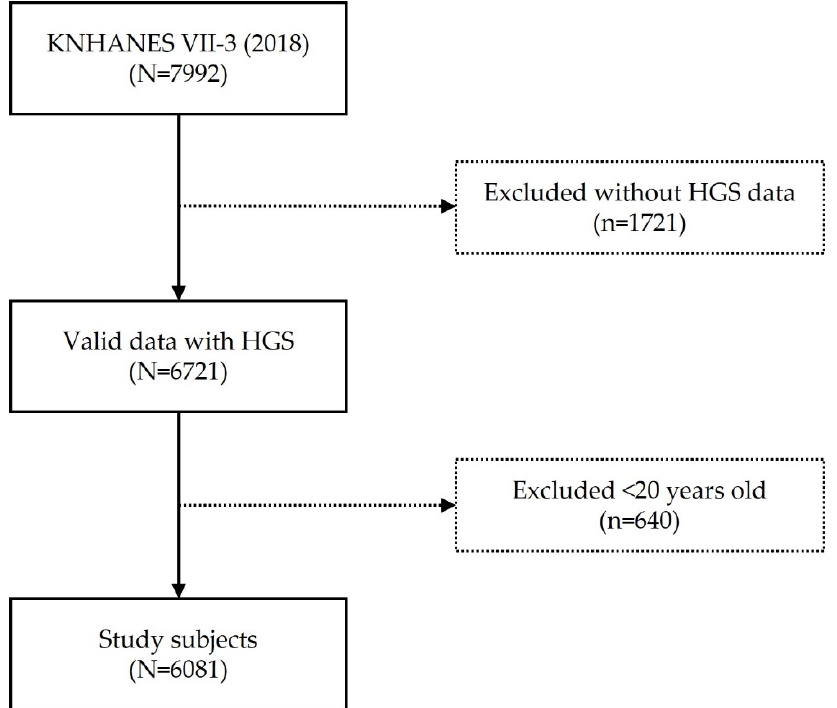
Figure 1. Flowchart. Figure 1.